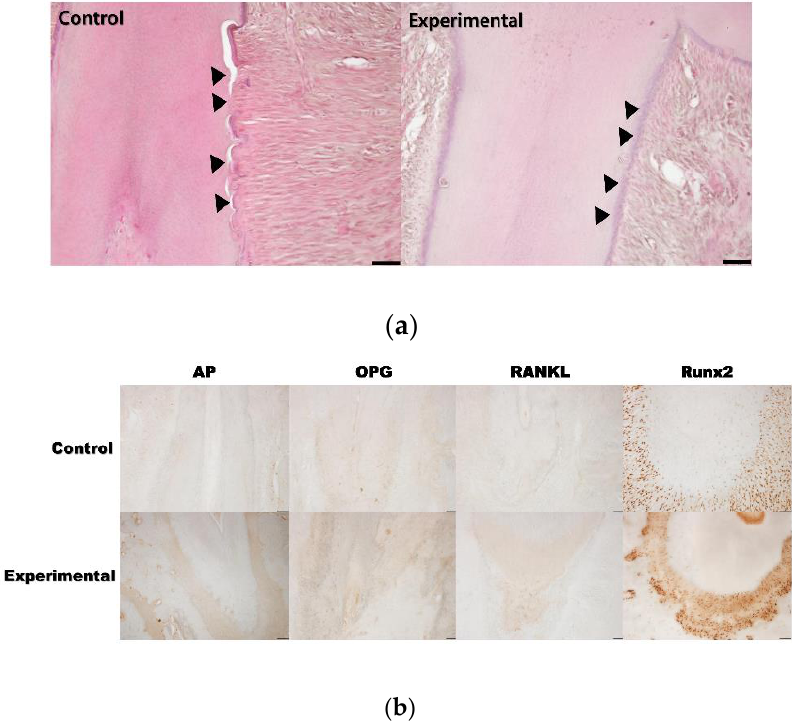
Figure 5. The results of histological analysis. ( a ) The control group showed multiple root resorptions (arrow heads). Thin cementum is shown in a violet color, and it was discontinuous because of root resorption. The experimental group showed continuous cementum (arrow heads, hematoxylin and eosin stain, bar = 50 µ m). ( b ) The immunohistochemical staining results demonstrated that positive staining for AP, OPG, RANKL, and Runx2 was mainly found in the periodontal ligament area. The staining intensity for each marker was stronger in the experimental group compared to that in the control group (original magnification × 200).